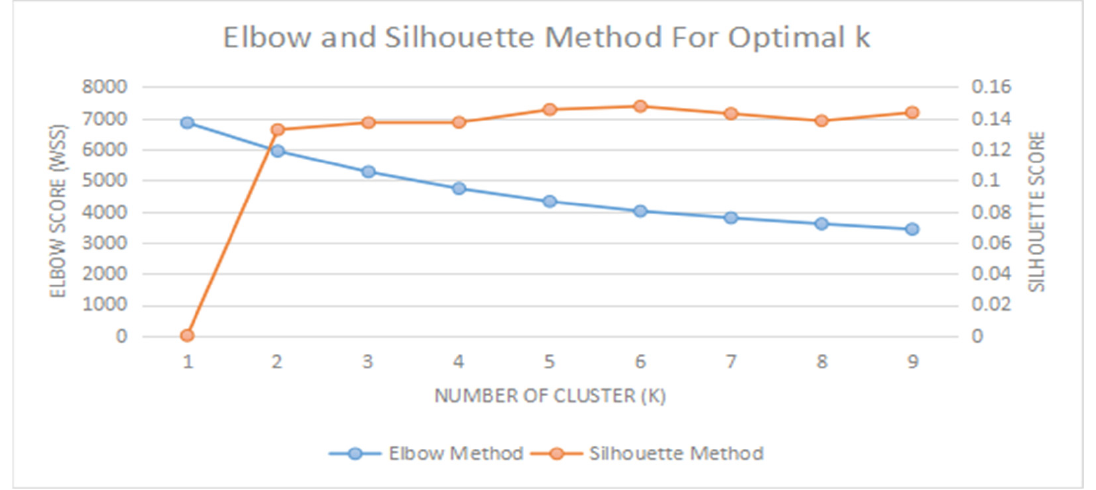
Figure 3. Optimal number of clusters .